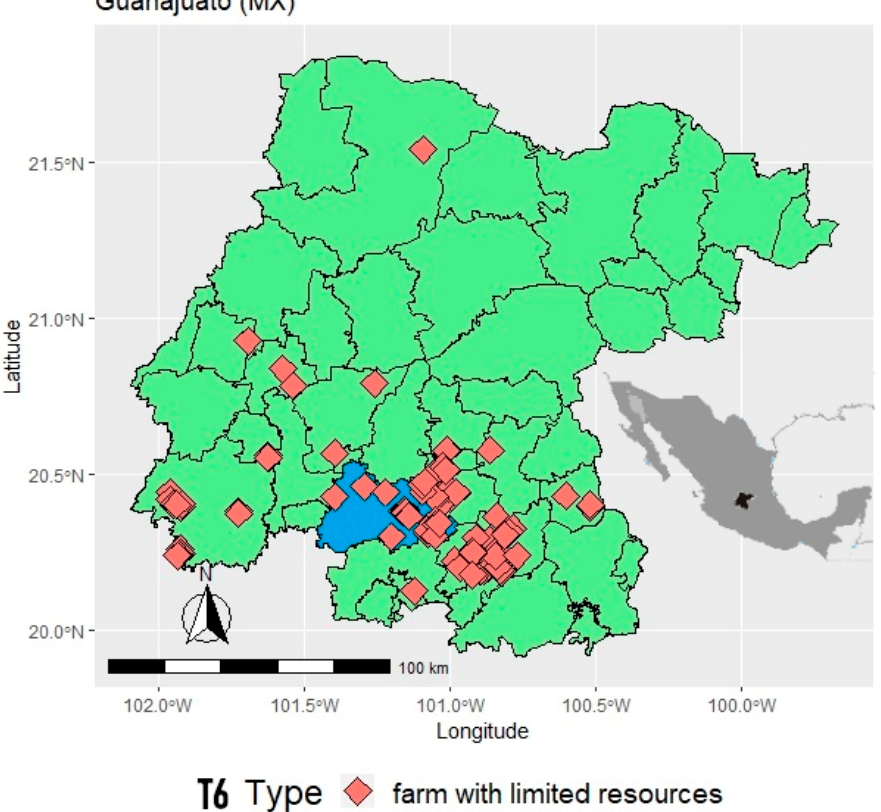
Figure 1. Geographical location of the focus of the research case study: representative farms (T6, red marks) in the State of Guanajuato (green area), central Mexico (gray inset) (Source: adapted from [52]).